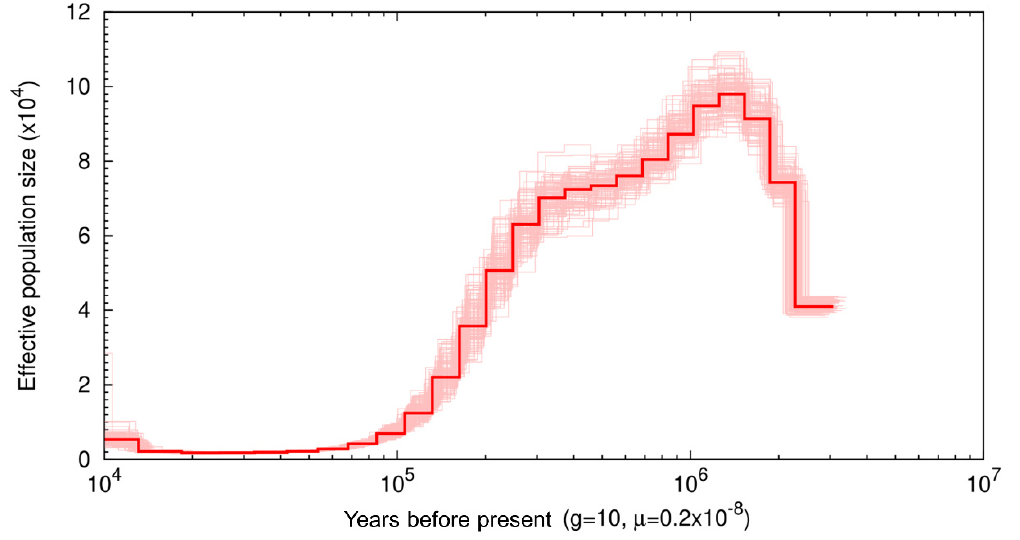
Figure 2. Pairwise sequentially Markovian coalescent (PSMC) plot of the muskox genome with 100 bootstrap repetitions assuming a generation time of 10 and substitution rate of 0.2 × 10 − 8 The x -axis represents time before present on a log scale and y axis represents effective population